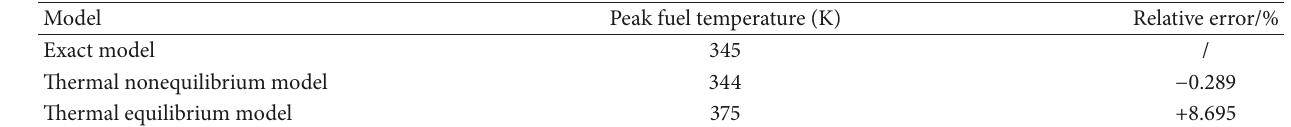
Table 2: Peak fuel